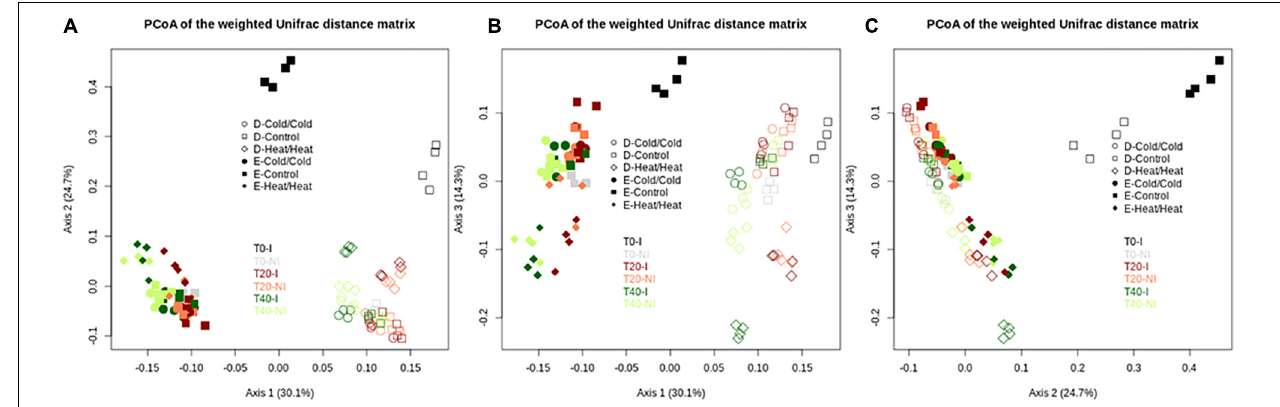
FIGURE 6 | Assessment of the effect of the invasive species on bacterial community compositions of soil E and soil D microcosms facing different disturbance sequences. Differences in community composition were estimated using the weighted UniFrac distance. Projections on PcoA axes 1 to 3 are represented on this figure (A–C) . Empty and filled symbols correspond to soil D and soil E, respectively. “I” inoculated microcosms; “NI” non-inoculated